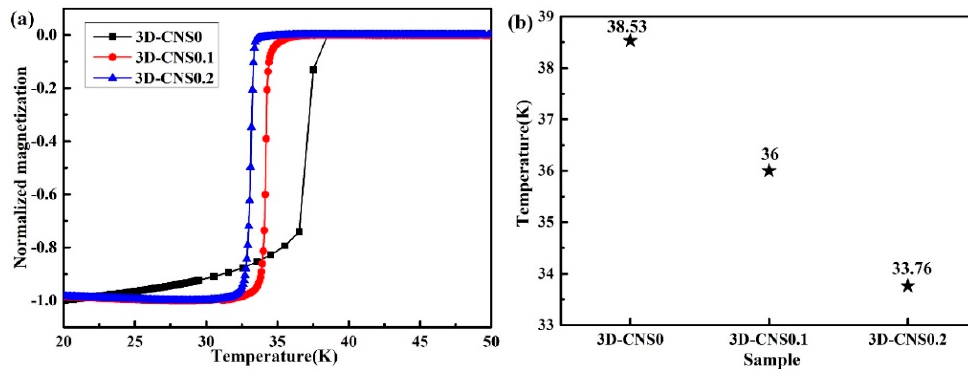
Figure 7. ( a ) Temperature dependences of normalized zero field cooled (ZFC) magnetization ( b ) T c comparison of doped 3D-CNS samples.